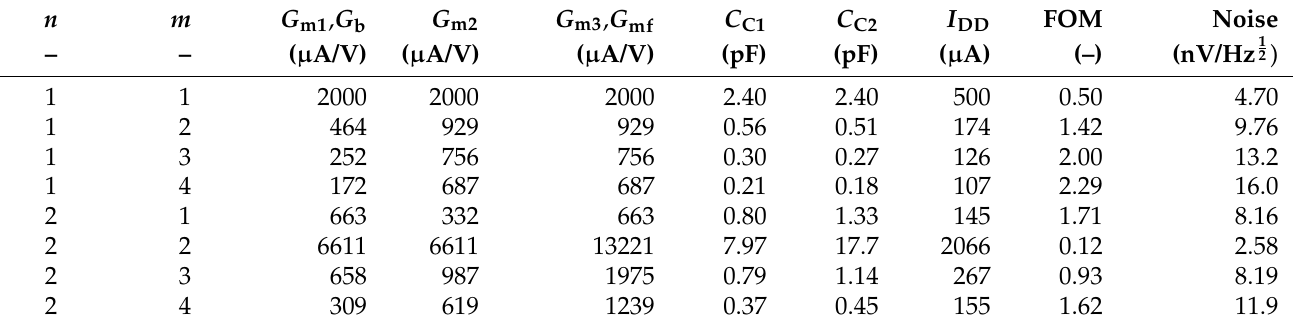
Table 2. Results of the dimensioning procedure.